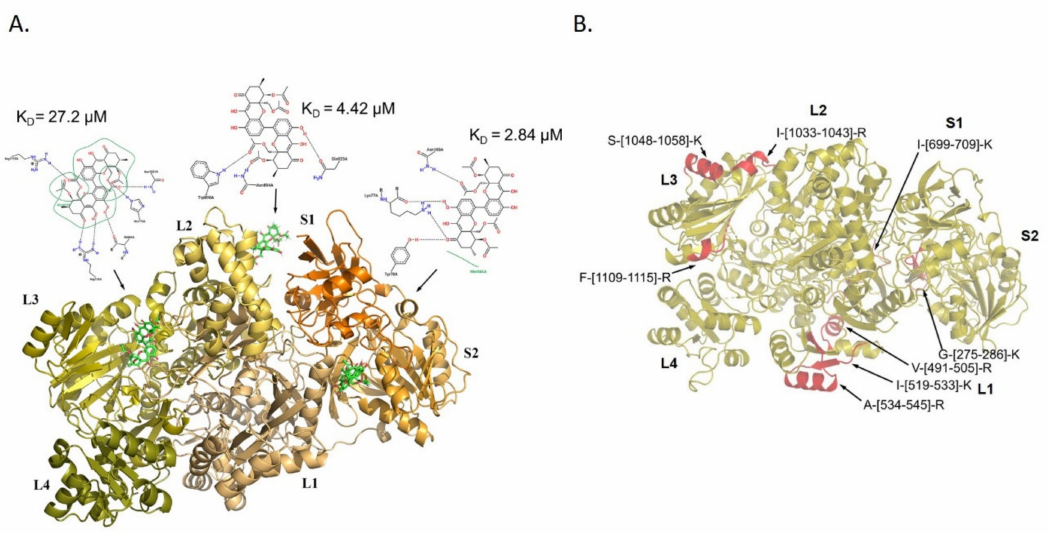
Figure 3. ( A ) The three best predicted complexes between PXA and CPS1 obtained using the molecular docking. CPS1 regions, showed in cartoon mode, are labeled and reported with di ff erent colors. Equilibrium dissociation constants K D for each binding pose and the amino acids involved in the interaction with PXA (showed as green sticks) are reported in the 2D pose depictions. ( B ) CPS1 3D structure is depicted in gold and the PXA-protected peptides identified by targeted-Limited Proteolysis-Multiple Reaction Monitoring (t-LiP-MRM) in red and marked with the corresponding